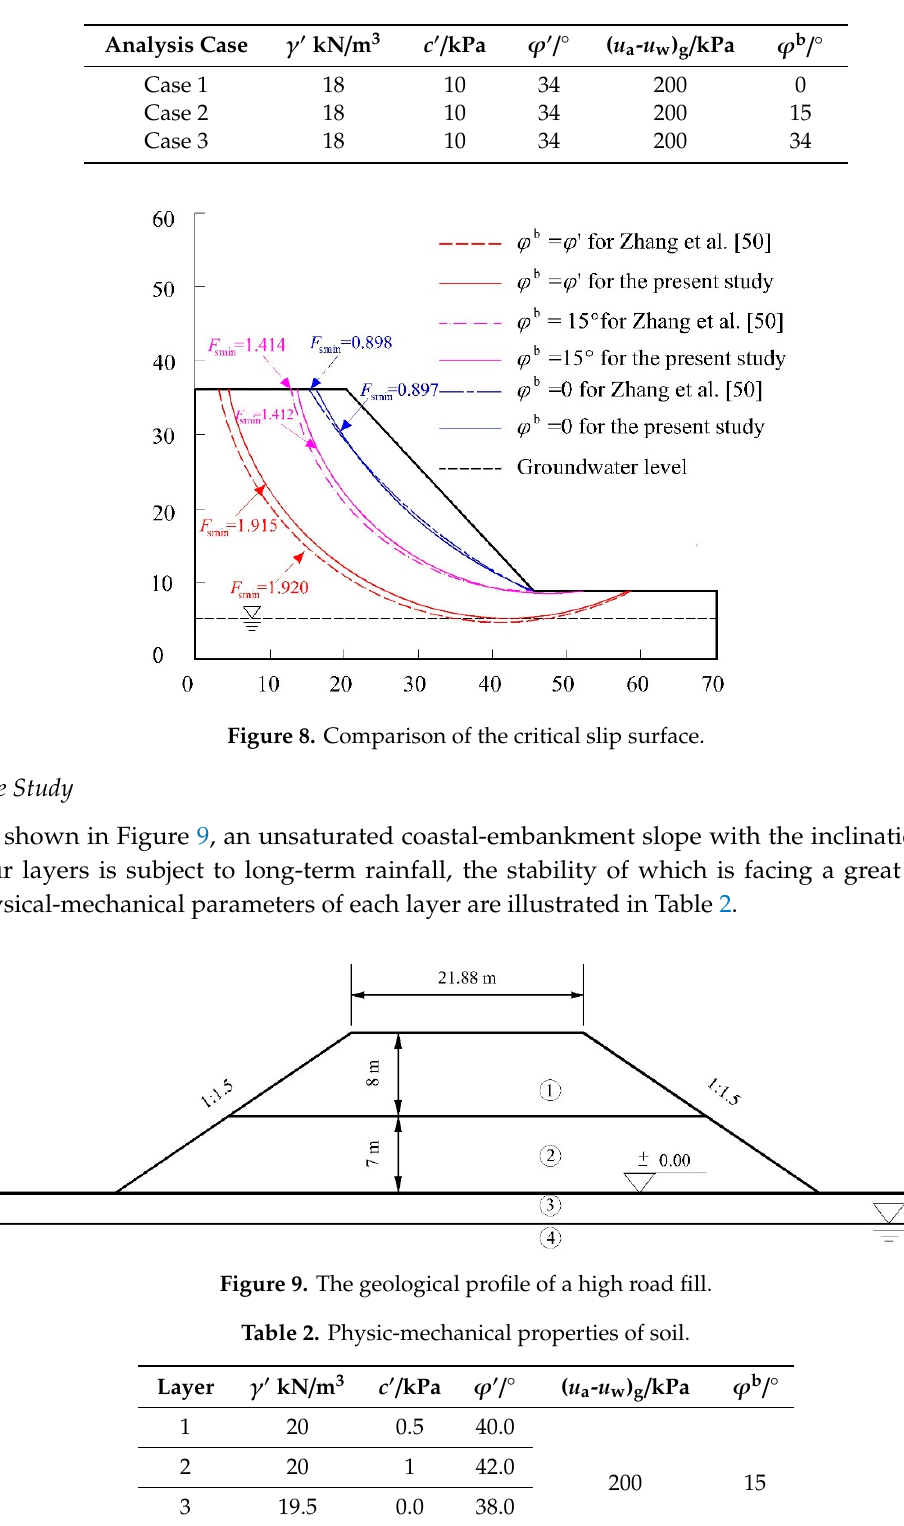
Table 1. Parameters of soil.